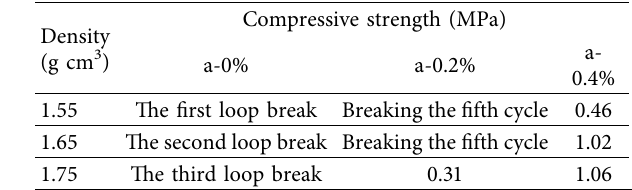
Table 5: Compressive strength after salt resistance test. Table 6: Compressive strength after alkali resistance test.